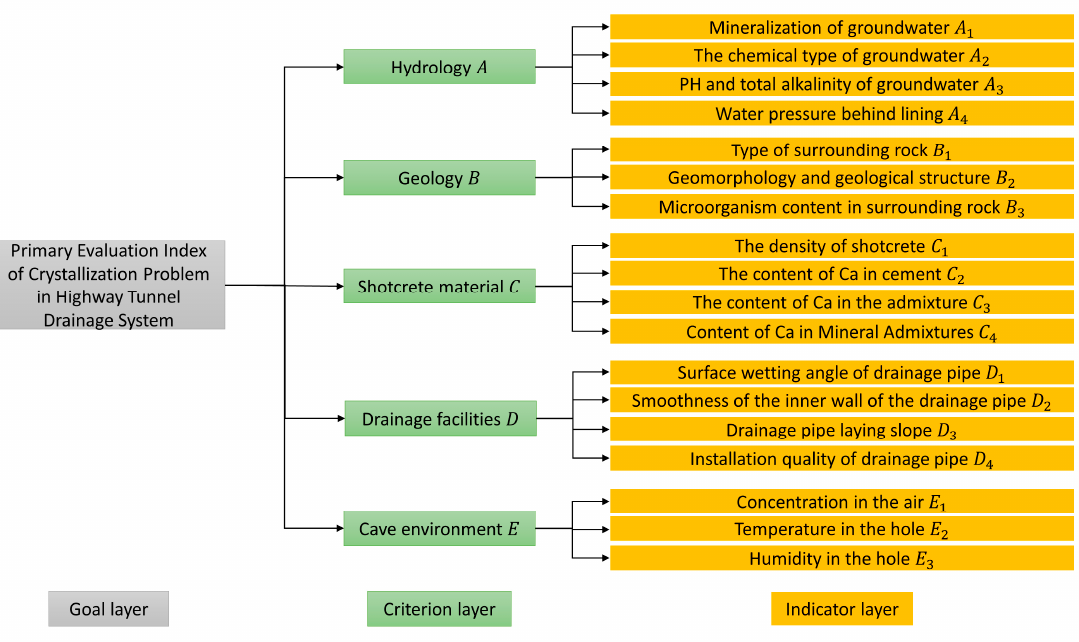
Figure 2. Preliminary selection of evaluation indicators affecting the crystallization of drainage systems in mountain tunnels.